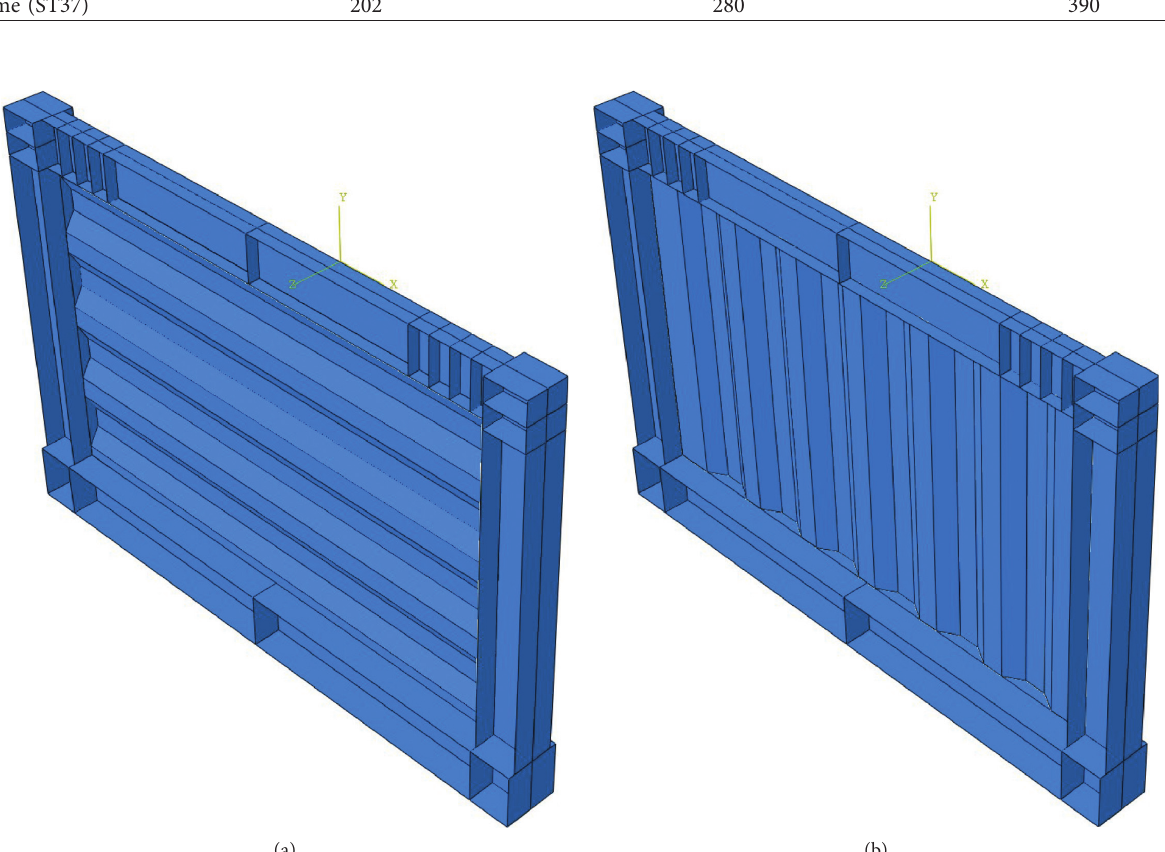
Figure 3: Typical finite element models. (a) Horizontal CSPSW. (b) Vertical